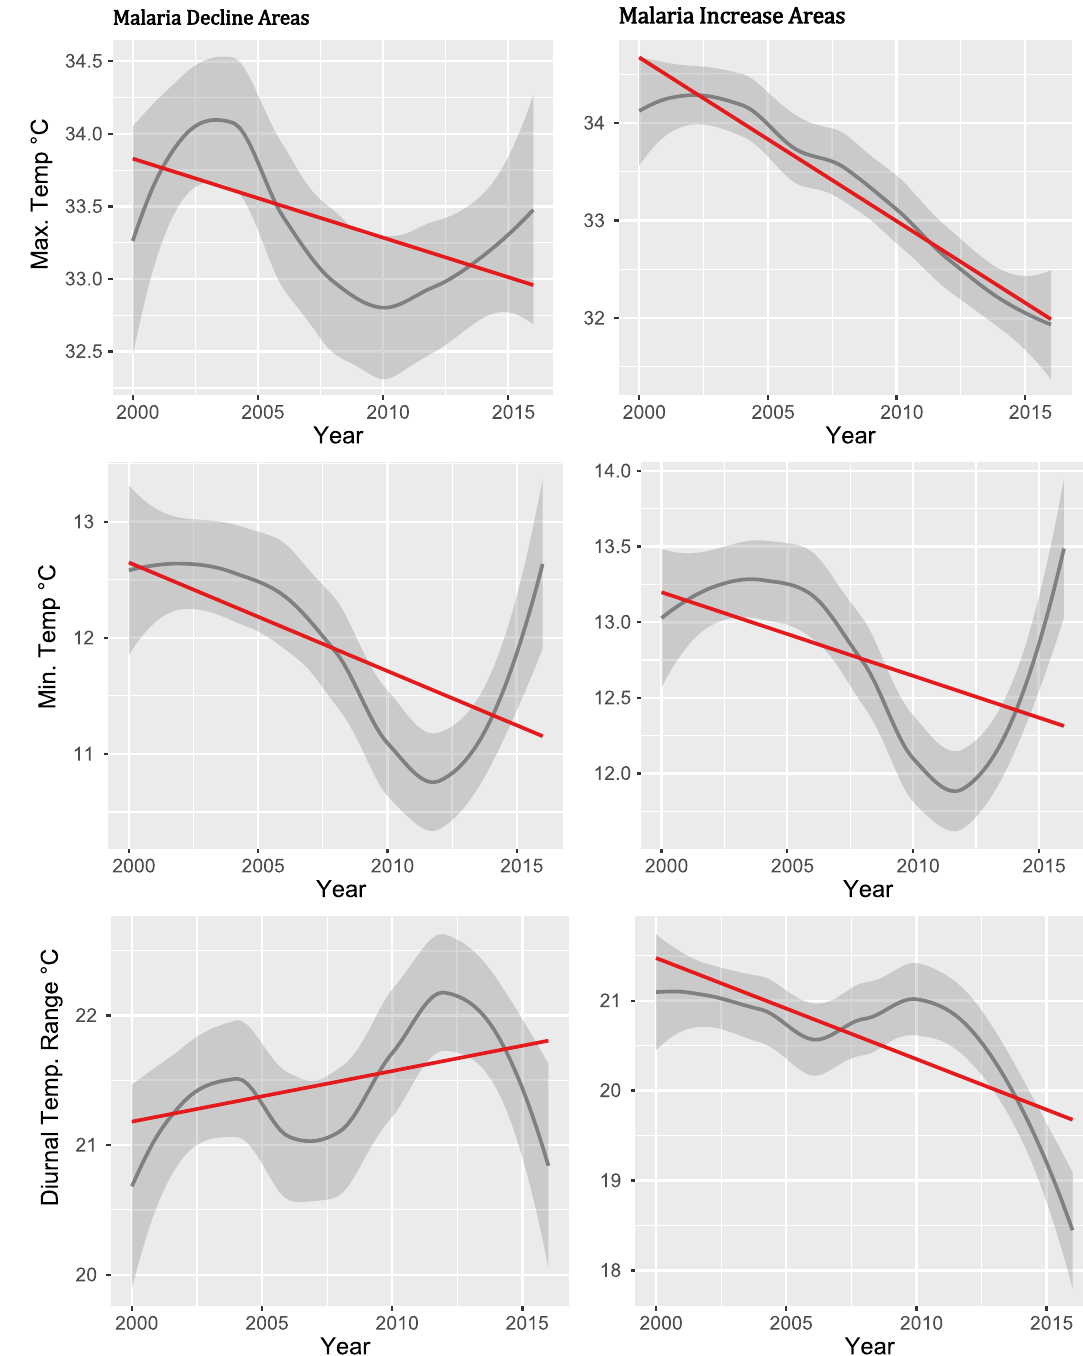
Figure 3. Temporal trends of temperature variables (using LOWESS smoothing function). Grey represents confidence intervals (95% CI) with 75% data. The red-line represents a linear best fit of the